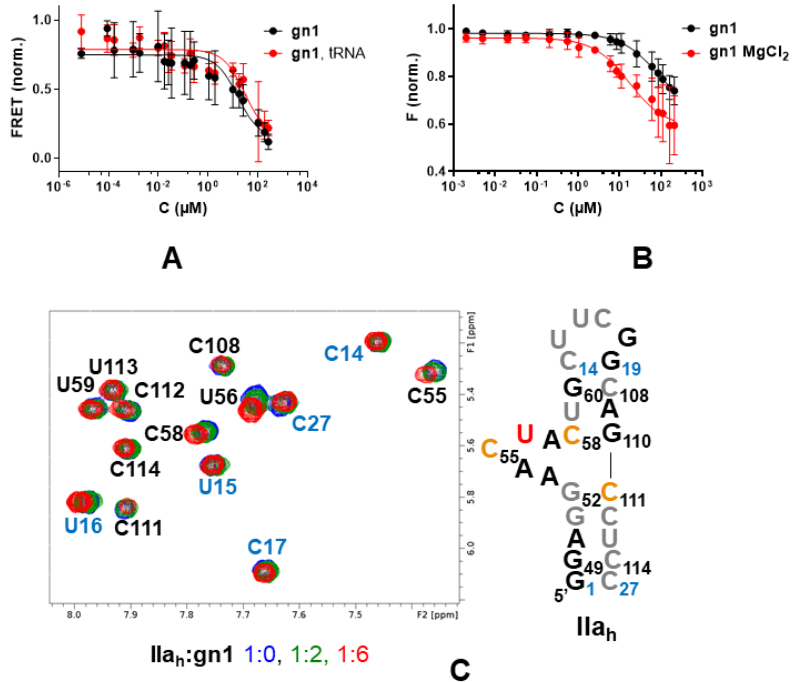
Figure 4. Interaction between HCV IRES subdomain IIa and selected pharmacophore hit gn1 . ( A ) IIa d FRET curves in the absence (black) or presence of a 100-fold molar excess of unlabeled competitor tRNA (red). ( B ) IIa h -F55 fluorescence intensity curves in the absence (black) and presence (red) of 2 mM MgCl 2 . ( C ) Titration of IIa h monitored by 1 H NMR spectroscopy in the presence of 2 mM MgCl 2 . The H5 ‐ H6 region of the TOCSY spectrum of unbound IIa h (blue) is superposed on the spec ‐ tra of complexes with increasing RNA: gn1 molar ratios, color ‐ coded as indicated in the graph. A map of the gn1 binding site in the IIa h hairpin is shown on the right. nt whose aromatic protons undergo chemical shift variations greater than two and three standard deviations from the mean perturbation (0.009 ppm) upon the addition of six equivalents of gn1 are highlighted in orange and red, respectively. nt with overlapped aromatic resonances are black ‐ colored, and residues with ar ‐ omatic signals not affected by ligand binding are colored grey. The terminal and capping UUCG tetraloop nt added to the viral sequence are indicated in blue and numbered differently.